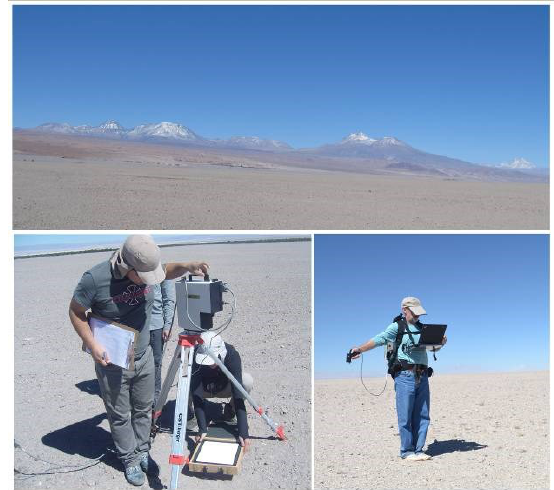
Figure 6. Field campaigns at "El Tambillo" calibration site, Atacama Desert,